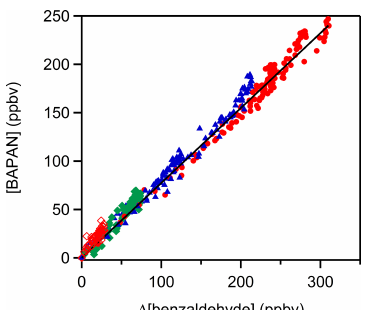
Figure 4. The plot of the logarithm (base e) of the ratio of the ini- tial benzaldehyde-d1 concentration to those at other reaction times against the logarithm (base e) of the ratio of the initial benzalde- hyde concentration relative to those at different times. Both ben- zaldehyde and benzaldehyde-d1 were competing for the same pool of NO 3 radicals. The slope of the plot is 0 . 53 ± 0 . 01. The red and blue circles represent two experiments with different concentrations of NO 3